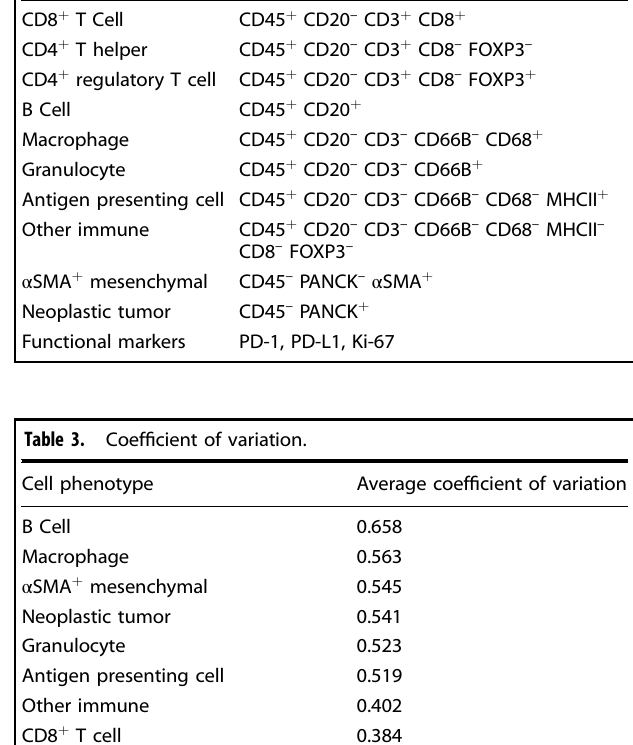
from tumors of other patients. Notably, we found no signi fi cant difference between “ Inter-Patient (Same Anatomic Site) ” and “ Inter-Patient (all), ” indicating that tumor regions diverged by the same degree from regions sampled at the same anatomic site as they did from regions sampled at all three anatomic sites (oral cavity, oropharynx, and larynx) of the head and neck region (Fig. 1d). Finally, given the large proportion of neoplastic tumor cells comprising the TiME for many of the tumor regions, we assessed KL divergence using only the distribution of immune cells present and found similar results (Supplementary Fig. 1c). This indicates that immune cell composition is more similar within regions from the same patient than across regions collected from different patients.